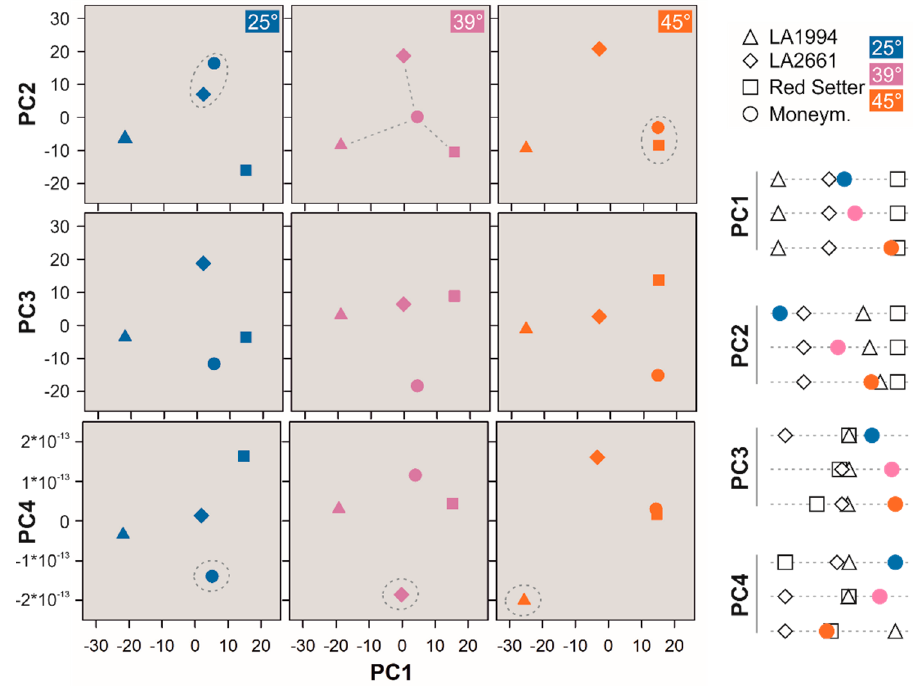
Figure 4. Principal Component (PC) analysis for different genotypes at a given temperature. The PC1 and PC2 (top), PC3 (middle) or PC4 (bottom) of the distribution of the transcript levels (mean values) in the different genotypes was calculated and is shown for each temperature. The symbol and color legend are indicated on the right. The circle and the lines are drawn for the visualization of the relations. On the right, the distribution of the genotype in each PC at each temperature is illustrated. The distribution of the individual experiments is shown in Figure S4.